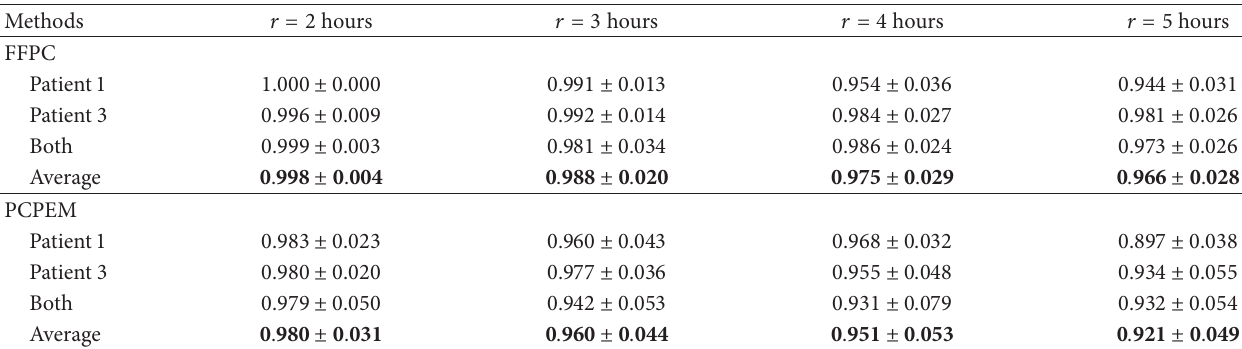
Table 5: The average classification accuracy (i.e., the proportion of all signal types correctly detected) using methods of FFPC and PCPEM with window size 𝑙 = 1280 for the epileptic seizure detection problem using different length of EEGs from Freiburg dataset, randomly selected from patient 1, patient 3, and both (mixtures of EEGs from both